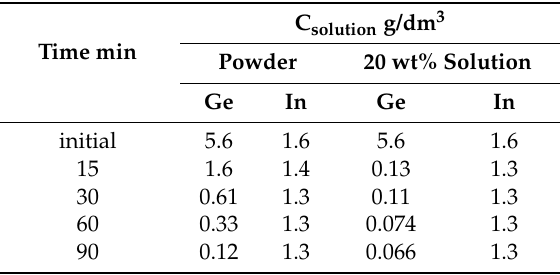
Table 5. Composition of the solution after precipitation with tannic acid powder and 20 wt% solution (90 ◦ C, 60 g/dm 3 active tannic added in 1